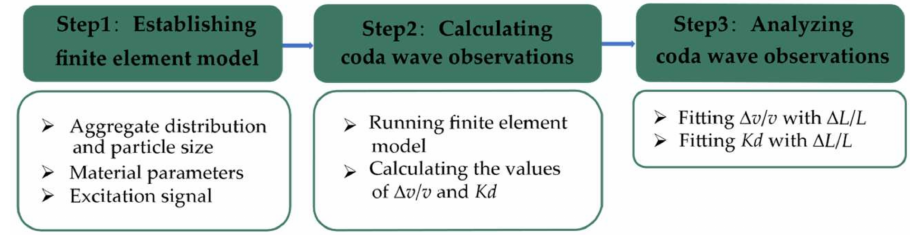
Figure 1. Flowchart of coda wave evolution in concrete using numerical simulation.